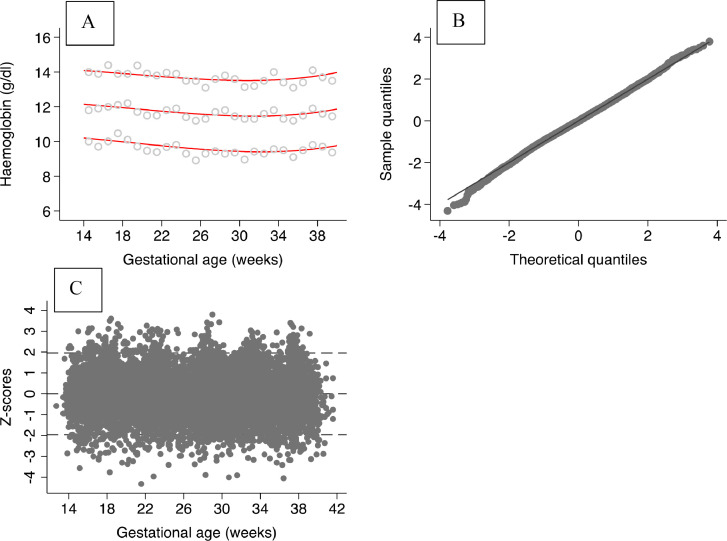
Goodness-of-fit plots showing (A) fitted 3rd, 50th and 97th smoothed centile curves of maternal haemoglobin (red solid lines) and open grey circles showing empirical values for each week of gestation (top left plot); (B) normal quantile‐quantile (Q‐Q) plots of the distribution of z‐scores (top right plot), and (C) a scatter plot of z-scores according to gestational age in weeks (bottom left plot).